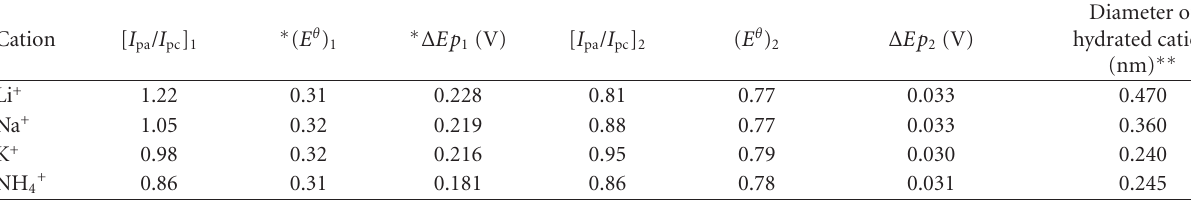
Table 1: Relationship between the diameter of hydrated cations and the electrochemical parameters of CuNPSD (electrolyte 1.0 molL − 1 ; v = 20mVs − 1 ; pH = 7.0).